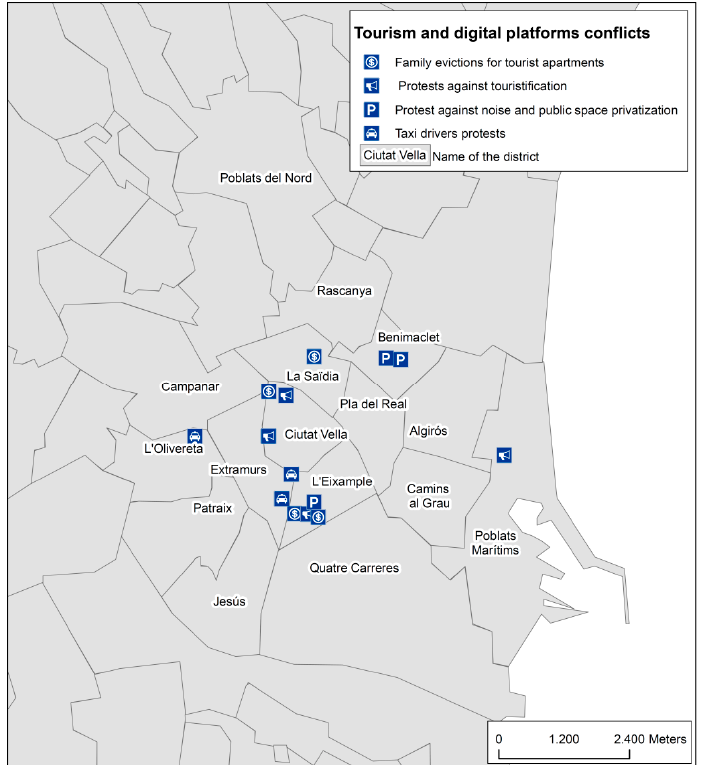
Figure 8. Tourism and digital platform conflicts, 2014–2018. Source: News database from El País, Levante, and Las Provincias. Levante, and Las